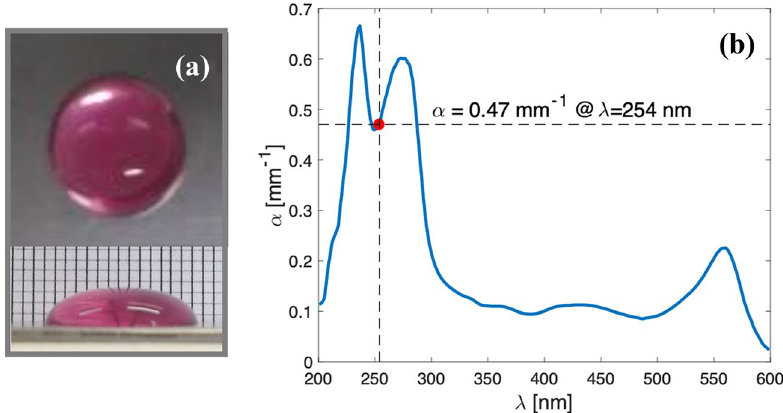
Figure 1. ( a ) Upper and lateral views of one of the DMEM drops used in the preliminary essays of this study. ( b ) Spectral variation of the absorption coefficient, α . The red circle represents the value of α = 0.47 mm − 1 at the wavelength of emission of the Hg lamps, (cid:31) Hg = 254